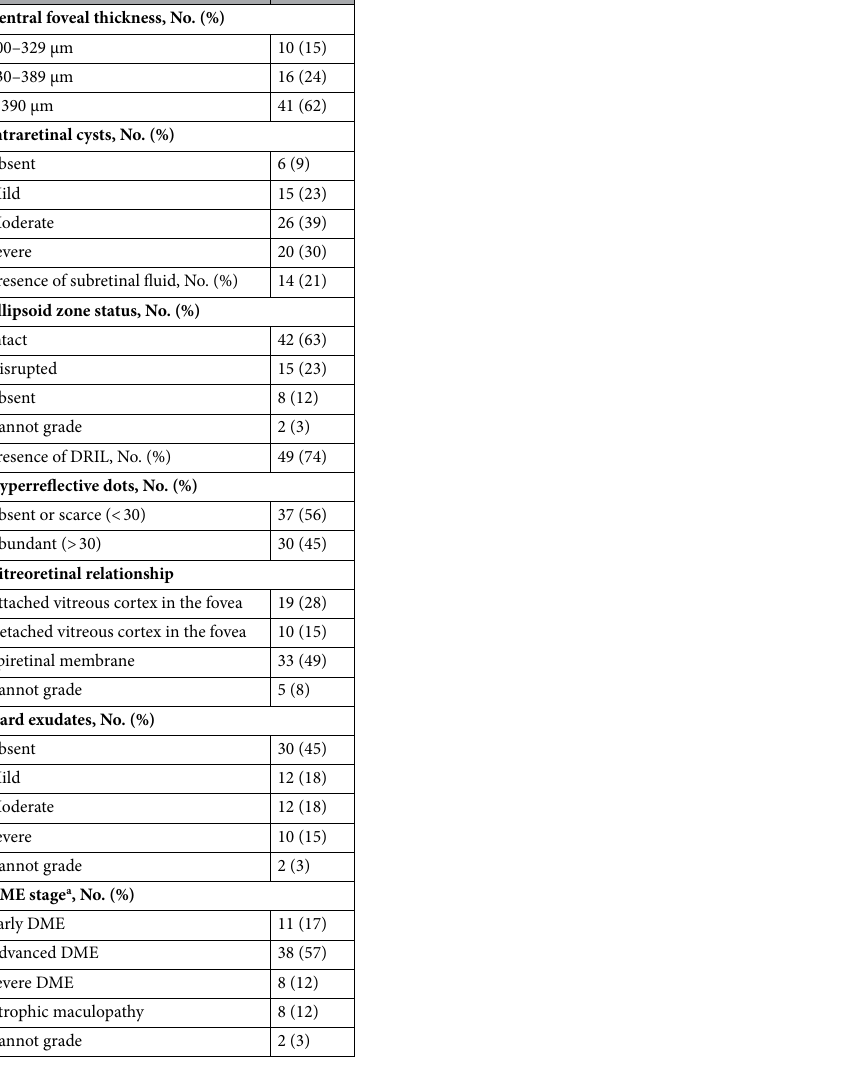
Table 2. Baseline DME imaging biomarkers. a DME stage was graded according to Panozzo et al.’s 21